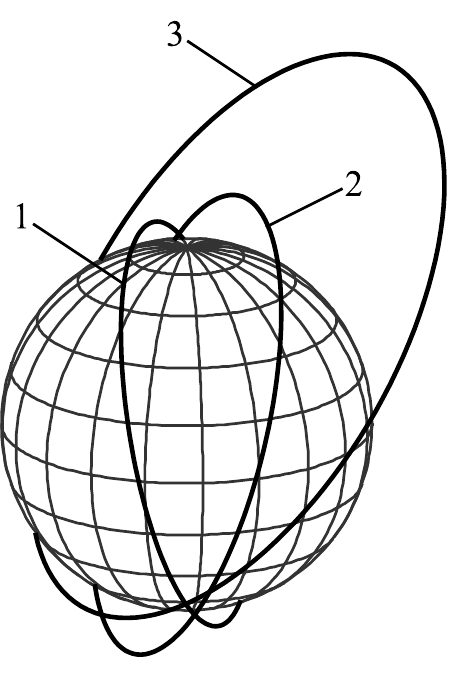
Figure 1. The mutual arrangement of multi-satellite group orbits. The numbers mark the orbits in the order presented in the above